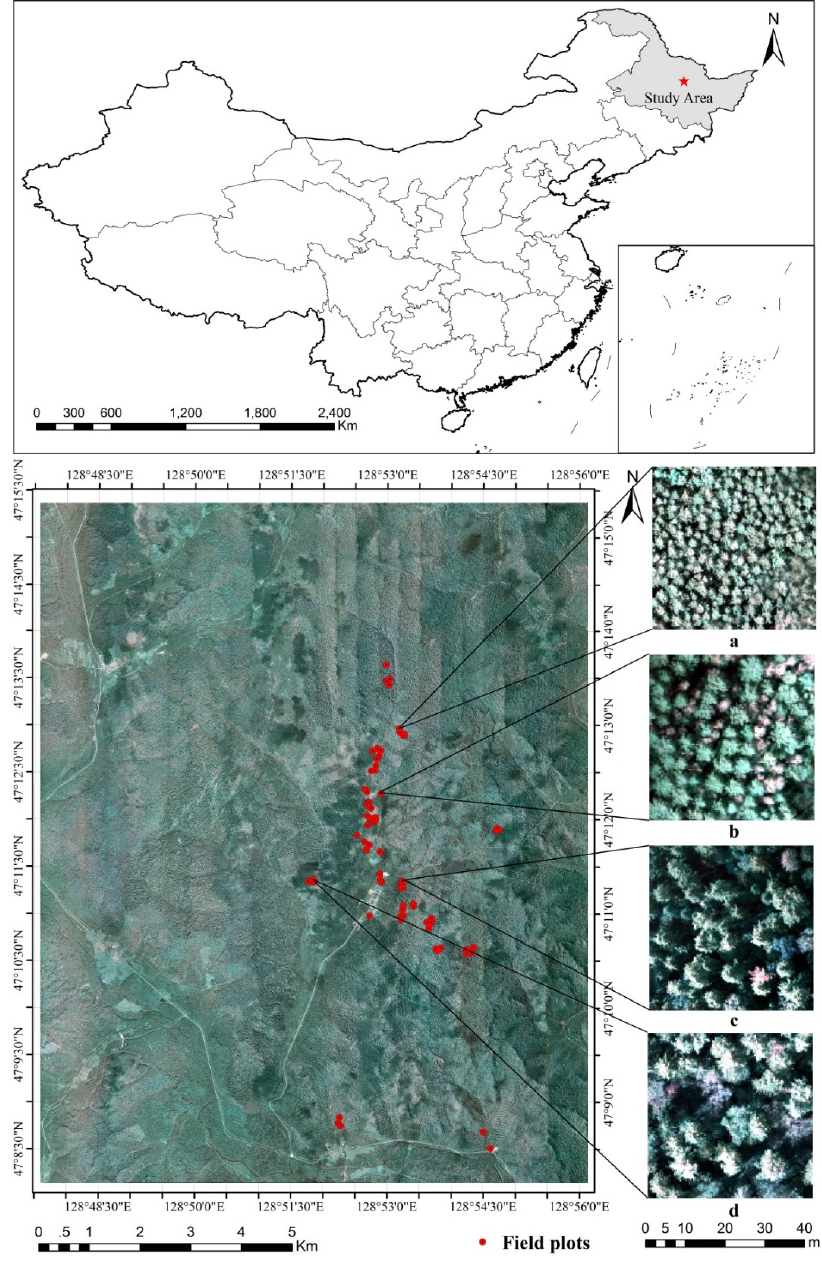
Figure 1. Location map of Liangshui National Nature Reserve in Northeastern China, aerial data were obtained for 26 flight strips in September of 2009. Seventy-four field plots measured in August 2009 are marked in red spots. Subplots of ( a – d ) show the samples for different forest canopy sizes (the average crown size for subplot ( a ) is 3.35 m; ( b ) is 4.69 m; ( c ) is 5.86 m and ( d ) is 7.57